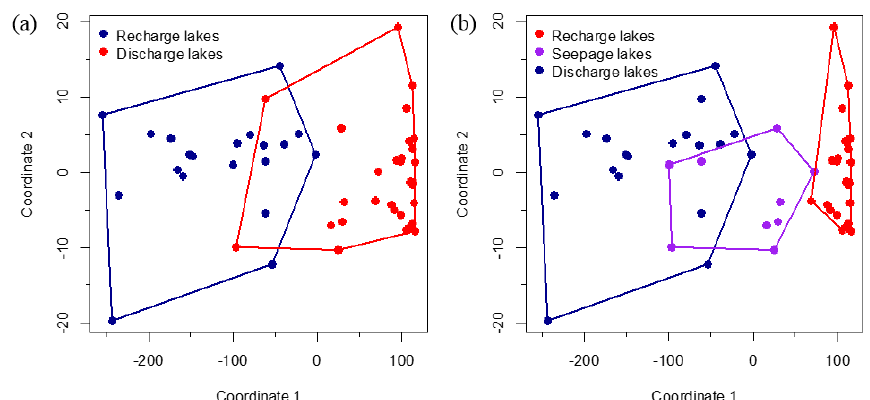
Figure 6. Non-metric multidimensional scaling (NMDS) applied to conservative and non-conservative water tracers. Lakes that occurred at an elevation greater than 282ma.s.l. are labelled as “groundwater recharge” lakes, whereas lakes located at an elevation less than 282ma.s.l. are labelled as “groundwater discharge” lakes (a) . A third group of lakes (labelled “seepage”) is further discerned based on chemical and isotopic characteristics (b) . The model converged after 35 iterations. Stress value for the NMDS is low (stress = 0 .